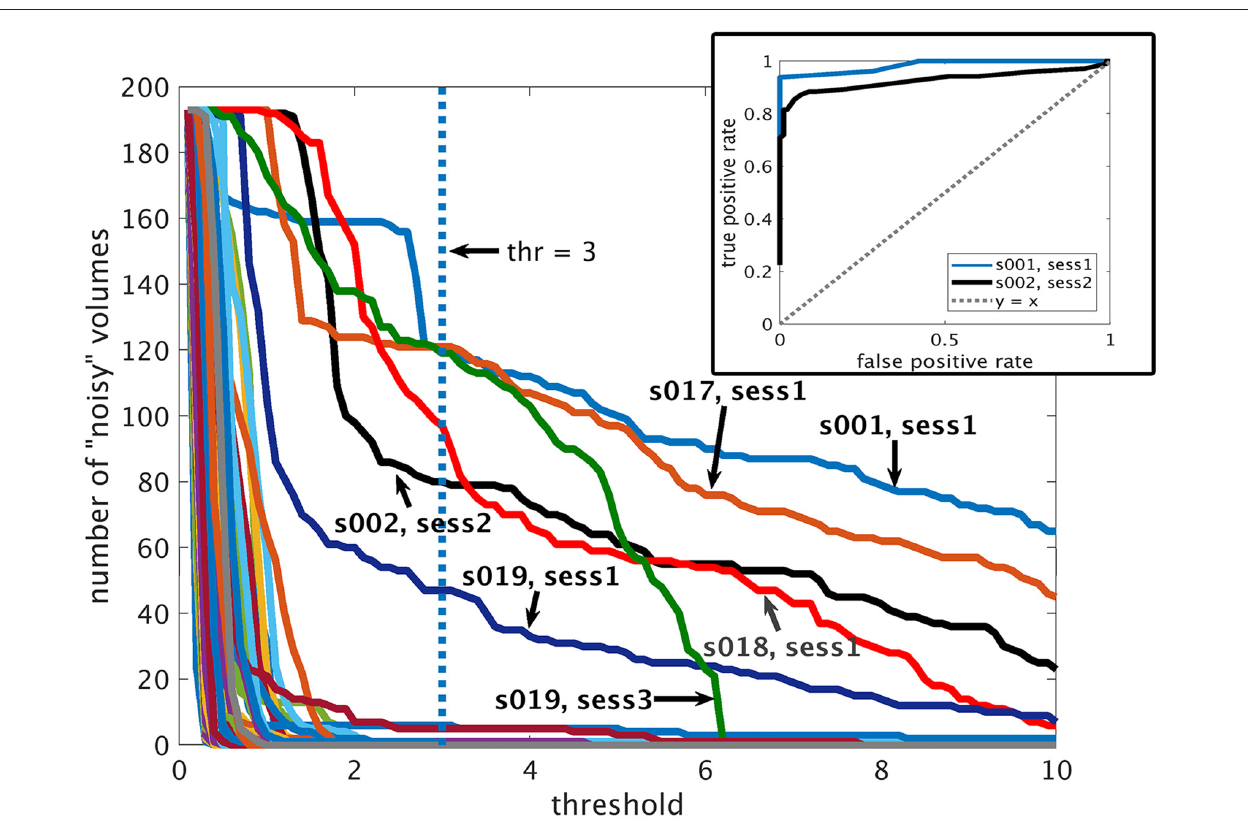
FIGURE 4 | Performance of the proposed automatic detection method. Plots of the detected number of volumes with gradient coil noise as a function of the threshold value ranging from 0.1 to 10 for all datasets. Inset: receiver operating characteristic (ROC) curves for two representative datasets (from subject 001 in S1 and subject 002 in S2) affected by gradient coil